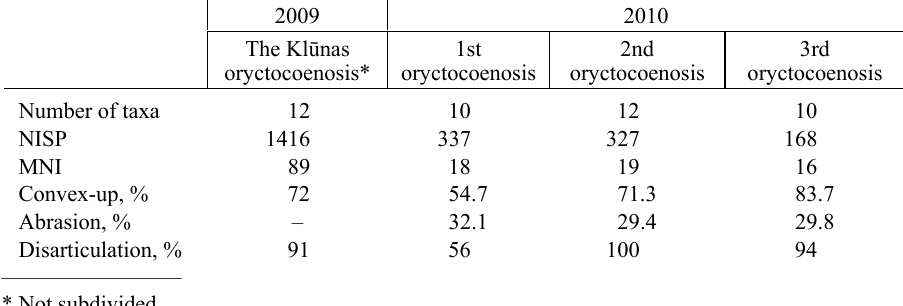
Table 1. Basic taphonomical data gained in 2009 and 2010 at the Kl ū nas site. NISP, number of identified specimens; MNI, minimum number of